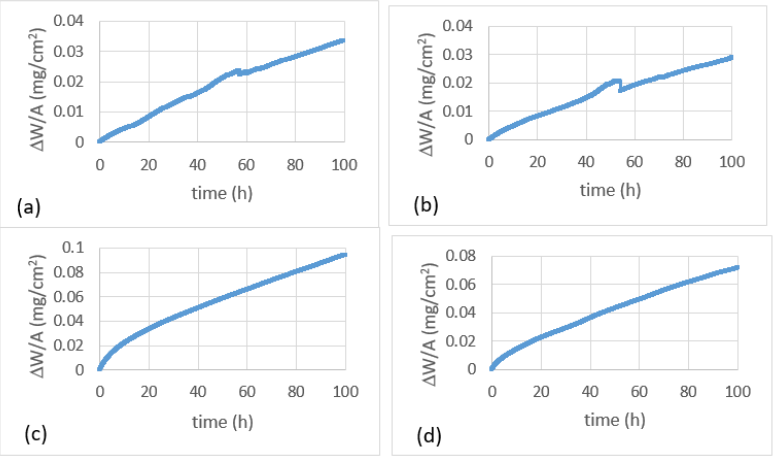
Figure 6. Thermogravimetric (TG) data for the alloys JZ1 ( a , c ) and JZ2 ( b , d ) for 800 °C ( a , b ) and 1200 °C ( c , d ).